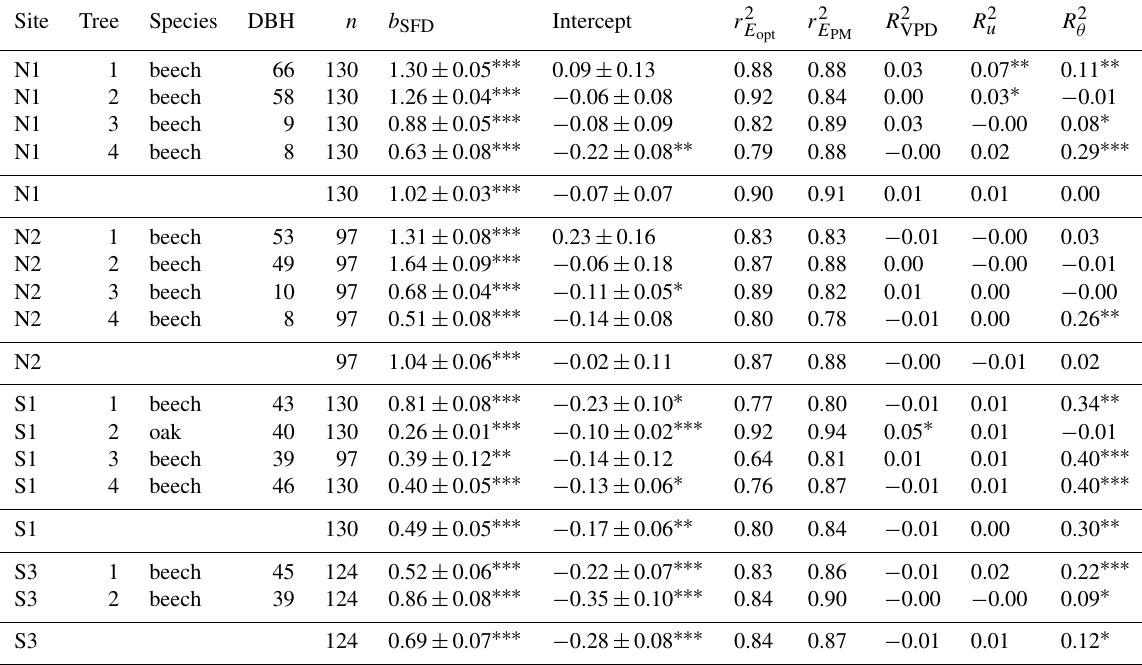
Table 3. Regression statistics of daily SFD as average per tree and per site as extra row. Column DBH is the diameter at breast height in centimeters. n is the number of observations (days). The slope b SFD and intercept of the linear univariate regression of SFD to E opt with ± σ reporting the estimated standard deviation of the coefficients. Significance of the coefficients is indicated by stars: p < . 001, ∗∗∗ ; p < . 01, ∗∗ ; p < . 05, ∗ . r 2 r 2 E opt and E PM , respectively. The last three columns report E opt and E PM are the linear squared correlation coefficients of SFD to the adjusted explained variance of a linear regression of the regression model residuals for the variables: vapor pressure deficit ( R 2 ), wind VPD speed ( R 2 u ), and site-average volumetric water content ( R 2 θ